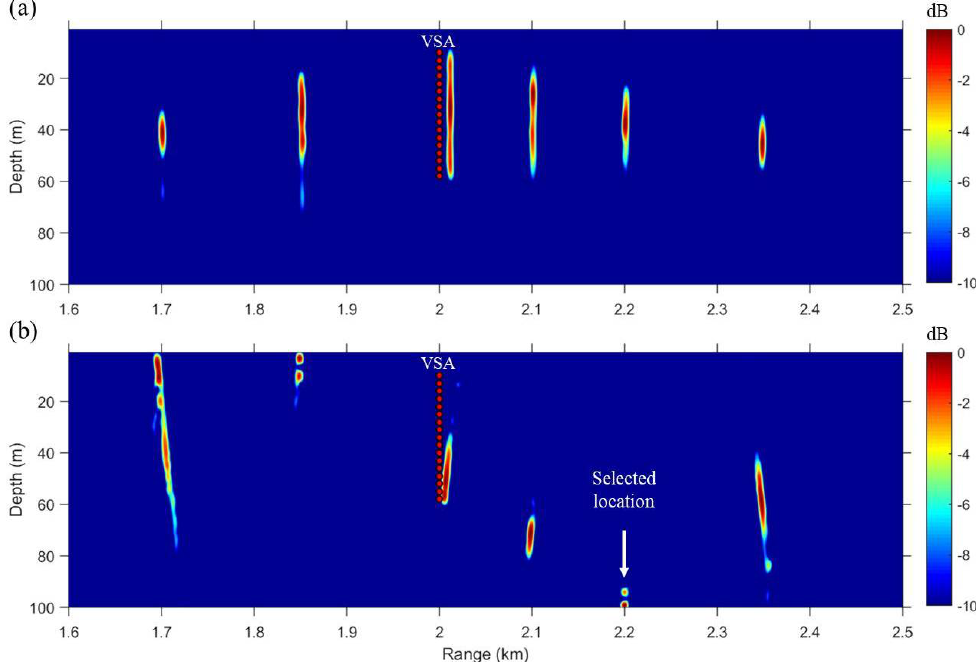
Figure 2. (Color online) Simulated VSA-based single TR focusing. Six snapshots of the backpropagated field from the TRM are superimposed with the corresponding snapshot times. Each snapshot is normalized with respect to its own maximum. ( a ) Without time delay (i.e., t n = 0) for a-priori sampled transfer functions; ( b ) Sampled transfer functions are appropriately time delayed; thus, it is clear that the synchronized field is steered over the VSA to a selected